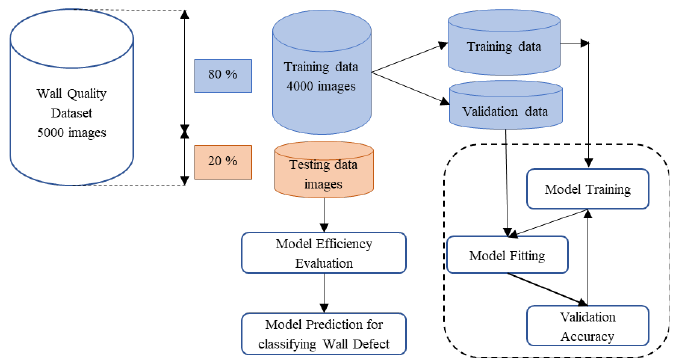
Figure 2. Deep learning activation layer model architecture.